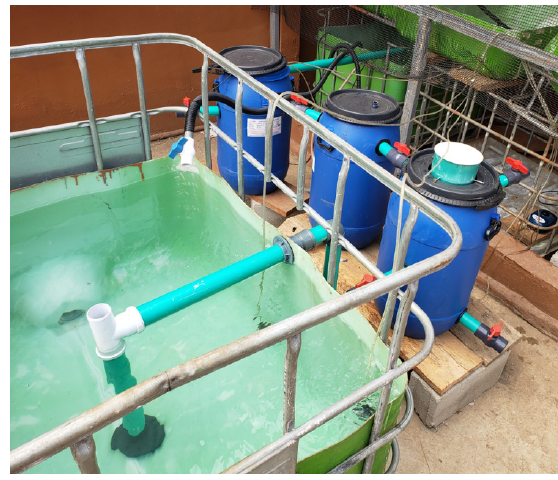
Figure 5. SANFU II RAS prototype implementation. Source: Authors.